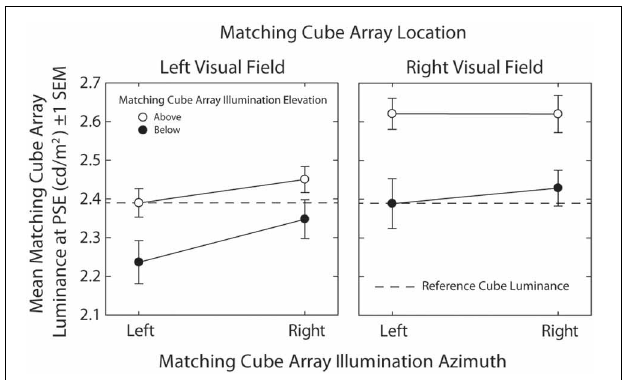
FIGURE 4 | Mean matching cube array luminance at PSE ( ± 1 s.e.m.) plotted as a function of matching array visual field (Left vs. Right) and illumination azimuth (Left vs. Right), with matching array illumination elevation (Above vs. Below) shown as a parameter.